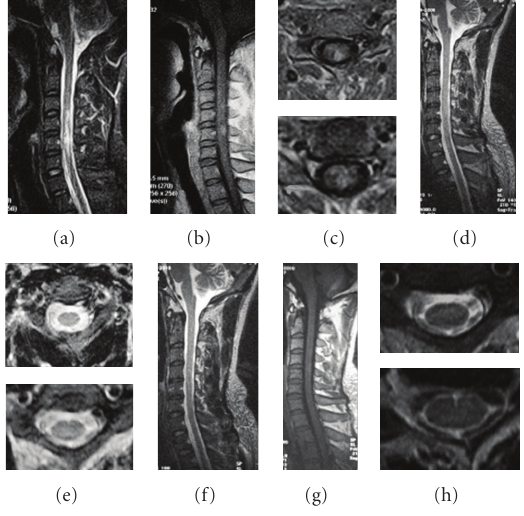
Figure 7: A 30-year-old male su ff ered from left paraparesis and paresthesias for 1 month. MRI of the cervical spinal cord revealed a demyelinating lesion in T2-weighted images extending from C4 to C7. Pulse methylprednisolone and IVIG were initiated with no resolution. The MRI changes are as follows:(a) sagittal T2-weighted image reveals a high intensity signal from C4 to C7 before ATT regimen, (b) sagittal T1-weighted MRI showing light thickening of the cord with subtle intraparenchymal hyperintensity, (c) the left local lesions on axial FLAIR sequences, (d) the hyperintensity resolved following 6 months of ATT, (e) no lesion is visible on axial T2-weighted images, and (f)–(h) no lesion is visible on follow-up MRI after 2 years of